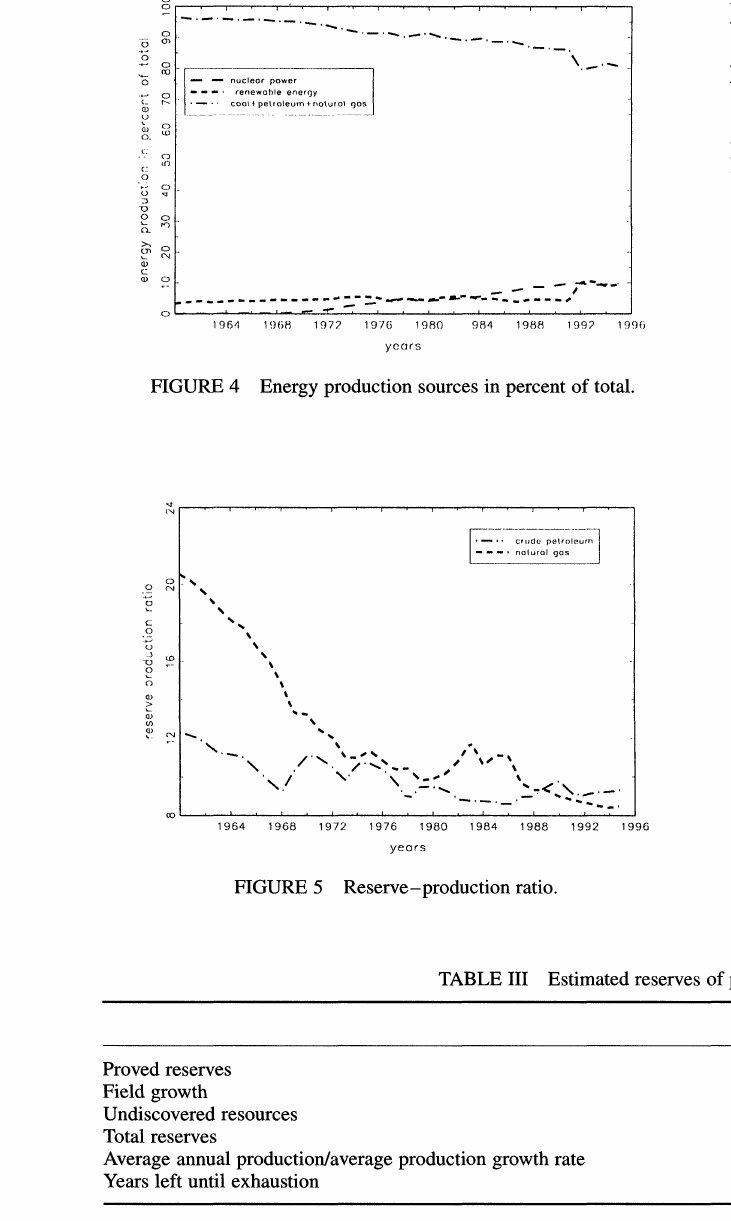
FIGURE 5 Reserve-production